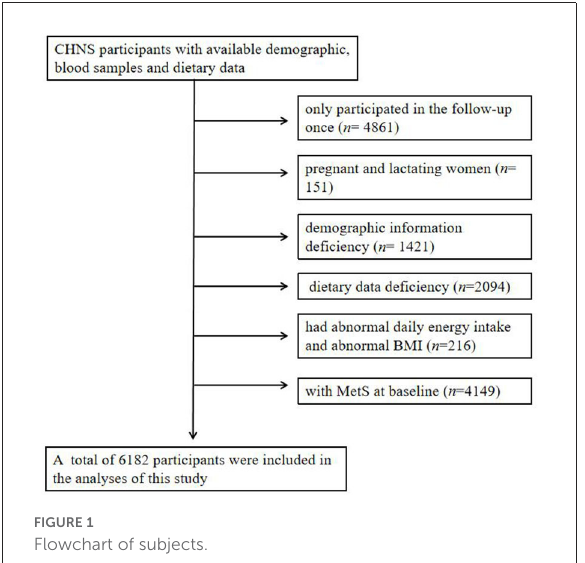
FIGURE1 Flowchart of